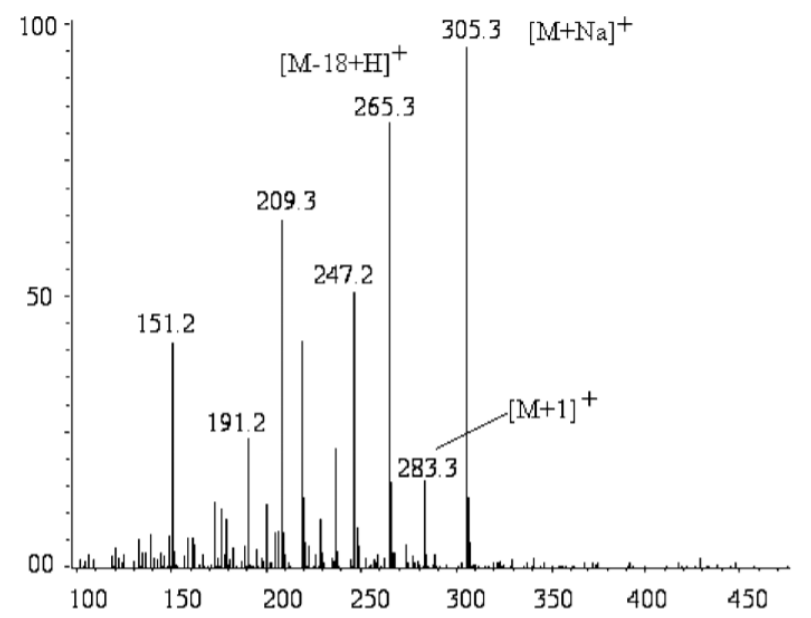
Figure 5. Mass spectrum of artemisinin under positive ion mode [41], where 283.3 [M + 1] + represents artemisinin; 305.3 [M + Na] + represents sodium adduct of artemisinin.